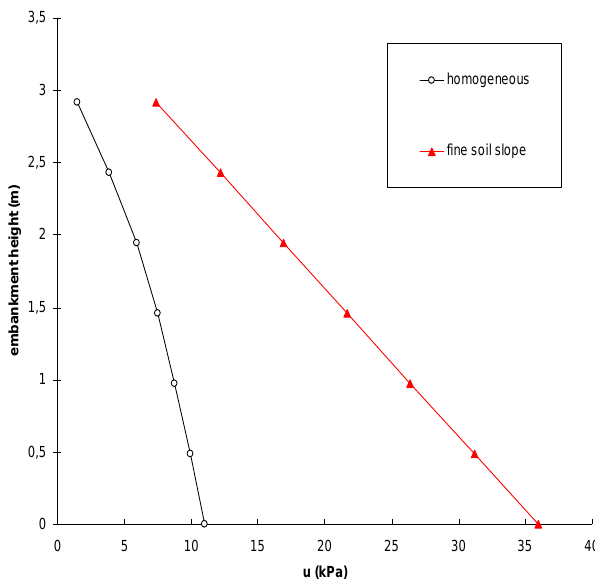
Fig. 12. Pore water pressures calculated at the downstream toe area Figure 12 – Pore water pressures calculated at the downstream toe area (see red line in Figure 4 (see red line in Fig. 8) at time t = 6h (see Fig. 9) for different em- 8) at time t = 6 h (see Figure 9) for different embankment configurations 5 bankment configurations.